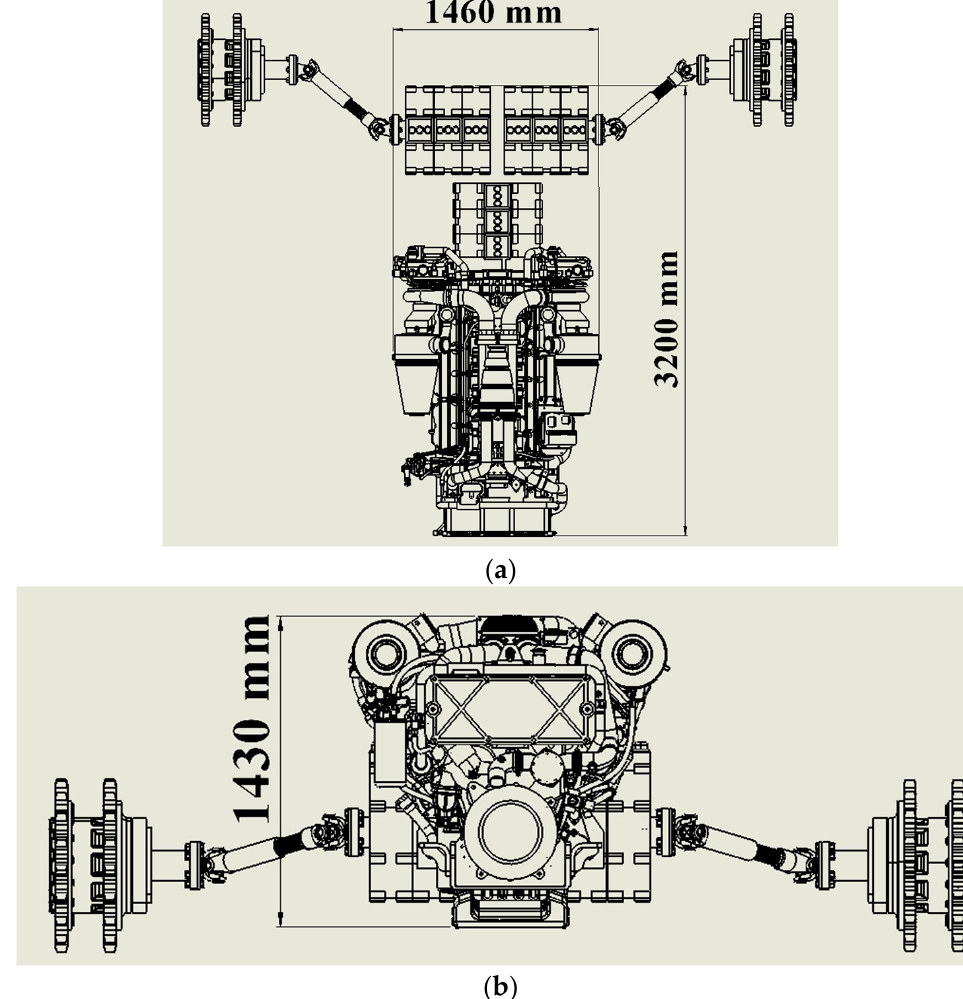
Figure 9. ( a ). Size of the dual drive power pack with a single diesel engine for a large MBT (Top View). ( b ) Size of the dual drive power pack with a single diesel engine for a large MBT (Side View).